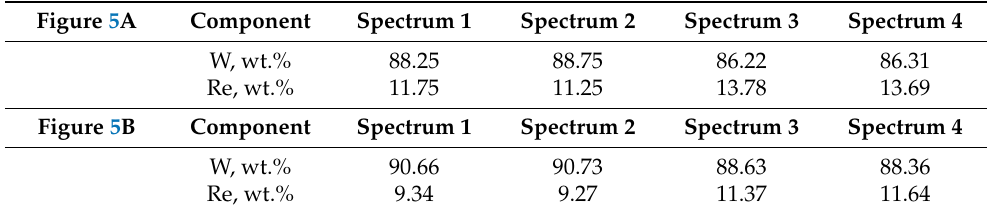
Figure 5. SEM images of cross-section of the sample after dealloying: ( A ) alloy after 3000 s; ( B ) alloy after 6000 s. Table 2. EDS analysis of cross-section of the sample after dealloying.